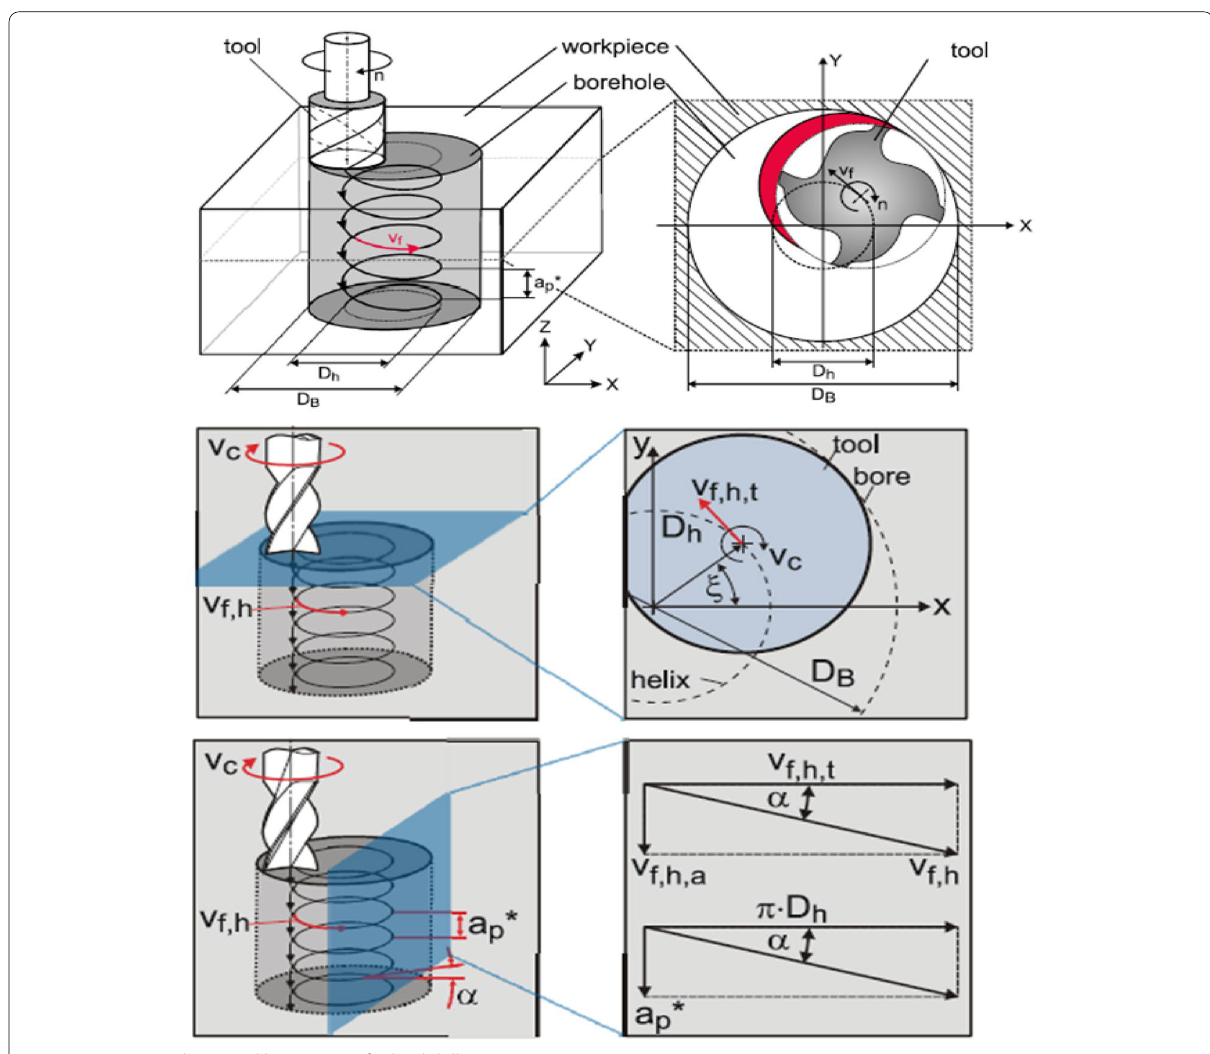
Figure 26 Moving locus and kinematics of orbital drilling